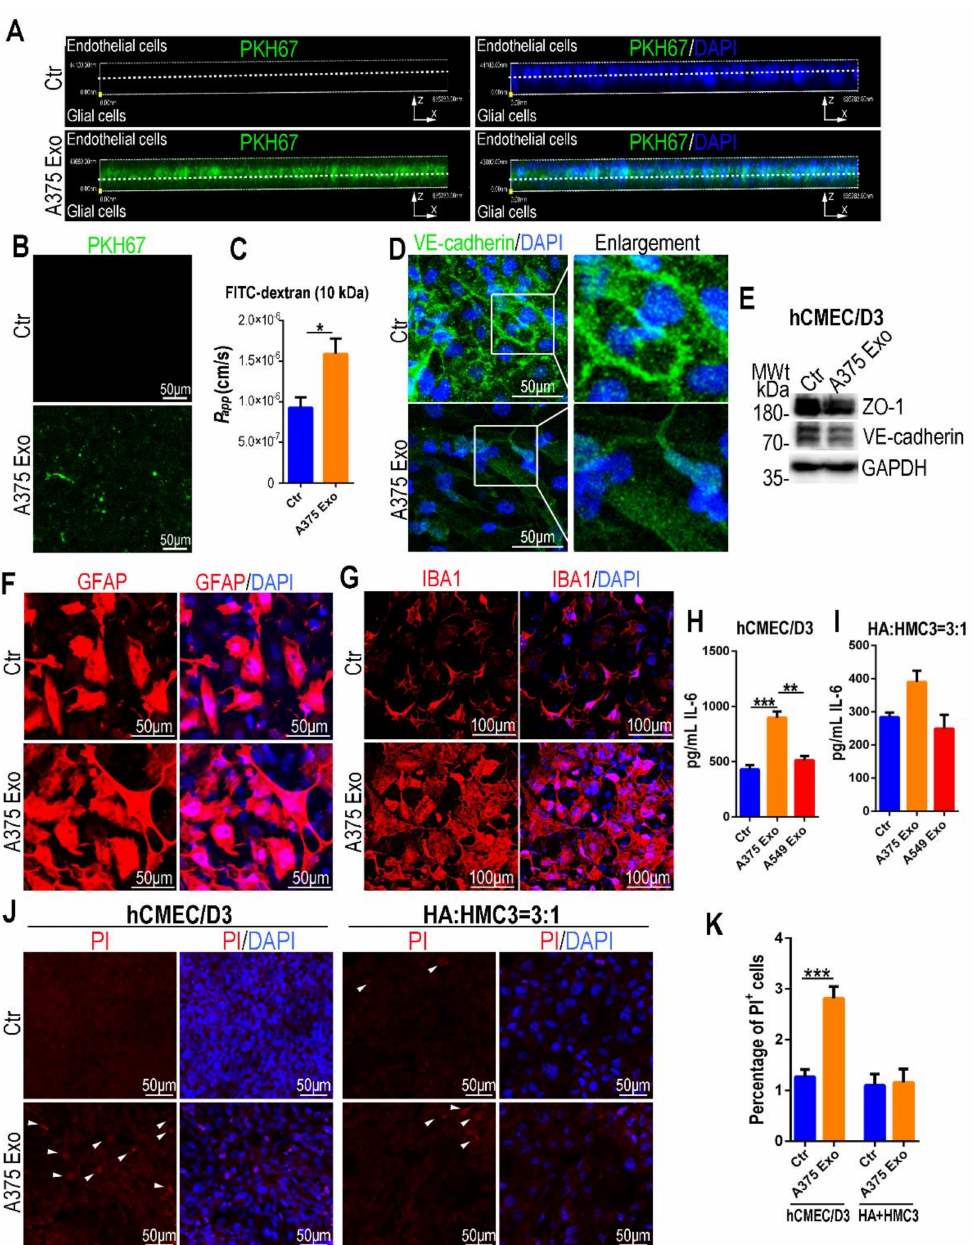
Figure 3. A375 cell-derived exosomes caused BBB damage and glial activation. ( A ) Side views of the BBB chip 24 h later following exposure of A375 cell-derived exosomes (green) to the vascular side ( n = 3). ( B ) Representative confocal images of glial cells 24 h later following exposure of